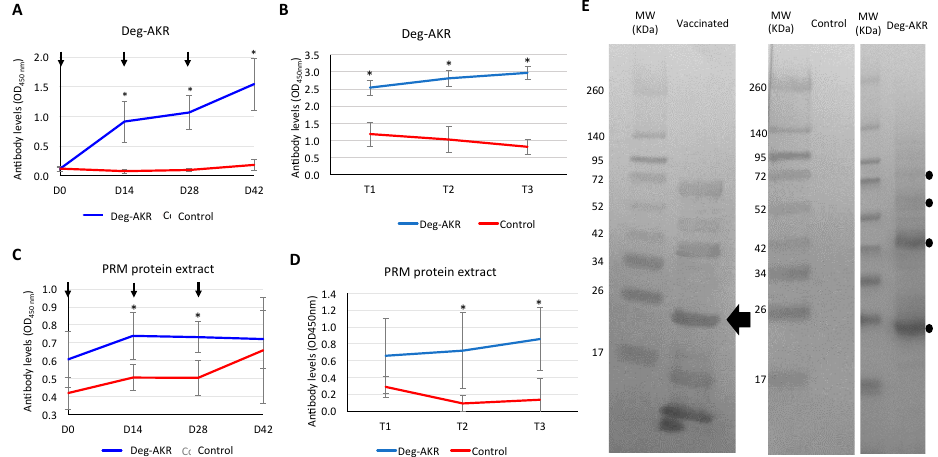
Figure 3. Antibody response to vaccination in hens. Serum samples were collected before each vaccination (arrows) and feeding device application (D42). Antibodies were extracted from eggs collected during two consecutive days on days 15–16, 29–30 and 42–43. Antibody titers are represented as the average OD450nm ± SD and compared between vaccinated and control groups by Mann-Whitney U test (* p < 0.05; N = 5). ( A ) Serum IgY antibody titers determined by ELISA against the recombinant Deg-AKR used for vaccination. ( B ) Egg yolk IgY antibodies titers determined by ELISA against the recombinant Deg-AKR used for vaccination. ( C ) Serum IgY antibody titers determined by ELISA against a PRM soluble protein extract. ( D ) Egg yolk IgY antibody titers determined by ELISA against a PRM soluble protein extract. ( E ) Characterization by Western blot of anti-Deg-AKR IgY. Ten micrograms of purified Deg-AKR were used for the analysis of pooled sera collected at D42 from vaccinated and control hens. The position of the recombinant Deg-AKR monomer (25.9 kDa) is marked with an arrow.